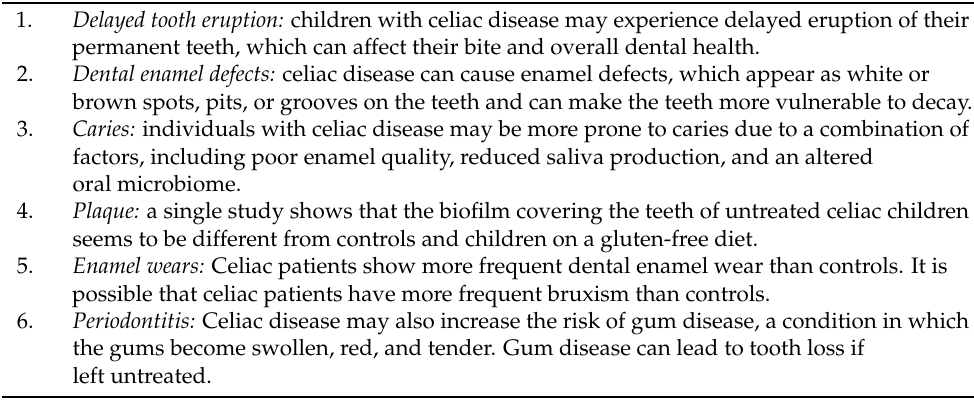
Table 4. Dental manifestation of celiac